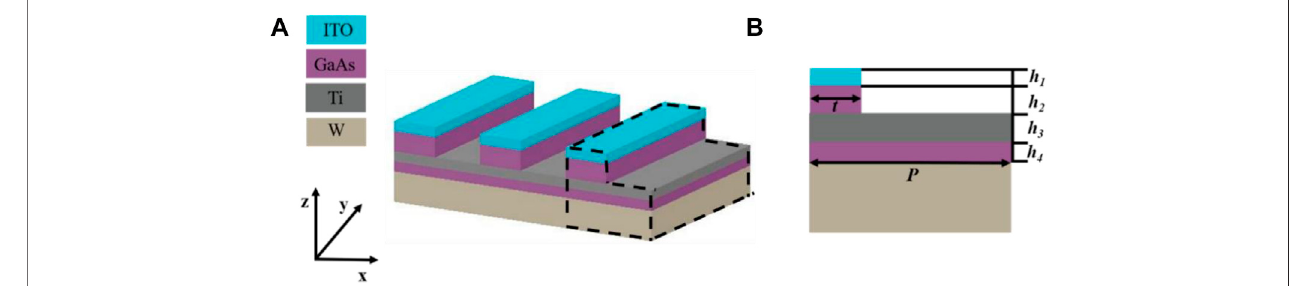
FIGURE 2 | Absorption spectra of multilayer broadband absorber with different con fi gurations.